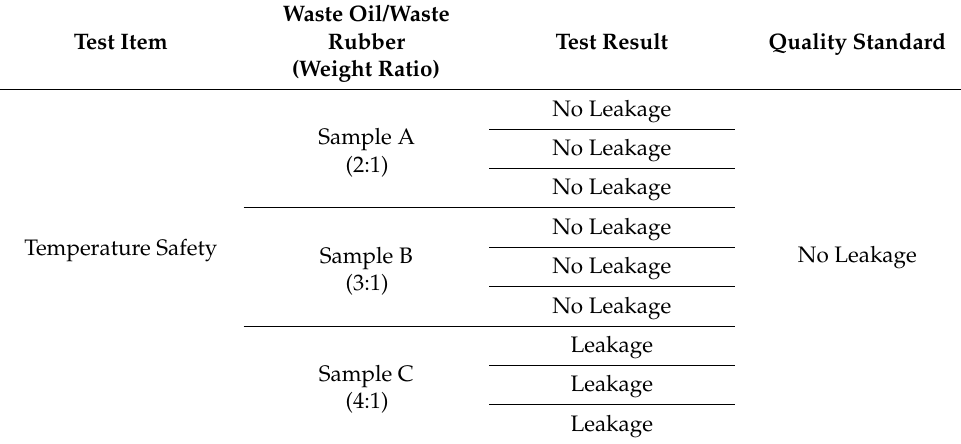
Table 7. Temperature safety by sample of W-SPRG.